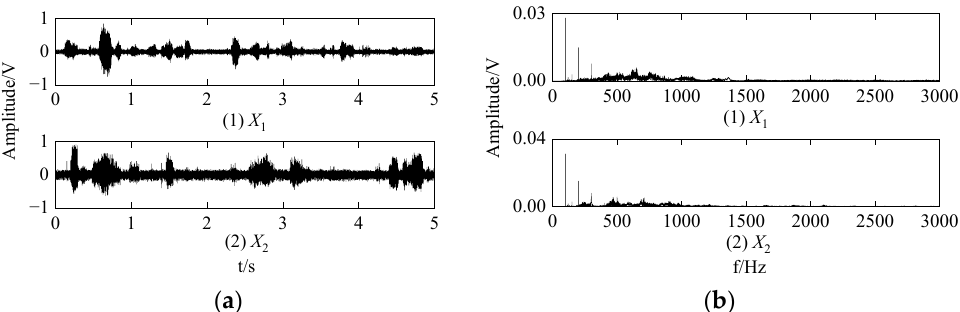
Figure 11. Waveforms and spectrums of the mixed acoustic signals in the substation; (( a ): waveform; ( b ): spectrum).